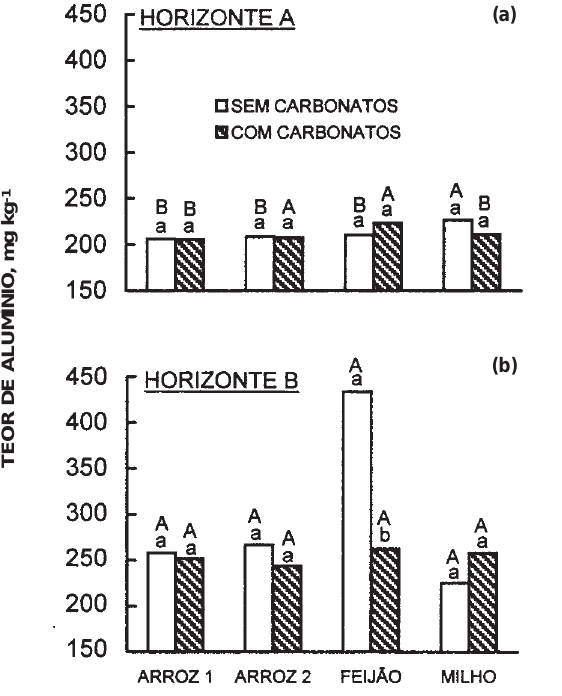
Figura 1. Teores de alumínio em raízes de plantas cultivadas em amostras dos horizontes A (com dm -3 de Al trocável) e B (com 0,8 cmol c 14,5 cmol dm -3 de Al trocável) de um Podzólico c Vermelho-Amarelo do estado do Acre, tratadas ou não com carbonatos de cálcio e de magnésio (Arroz 1, cultivar Fernandes; Arroz 2, cultivar IAC 1131). Letras maiúsculas e minúsculas acima das barras comparam horizontes e doses de carbonatos, respectivamente, pelo teste de Tukey a 5%.